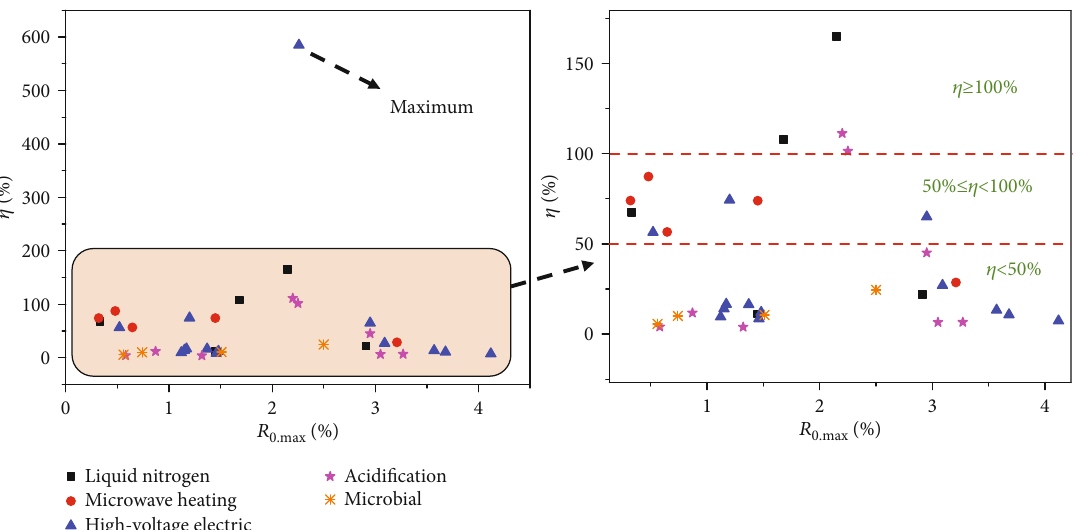
Figure 19: The pore change rate of di ff erent stimulation methods with maximum vitrinite re fl ectance (the data come from the literatures [20, 50, 72, 78, 79, 86, 94, 96, 123 – 132]) ∗∗ Note: (i) For the same coal sample with the same stimulation method, only the maximum η was used for plotting, and (ii) for the samples using microbial stimulation, the total pore volume was substituted into Eq.(1) instead of porosity because of the lack of data.